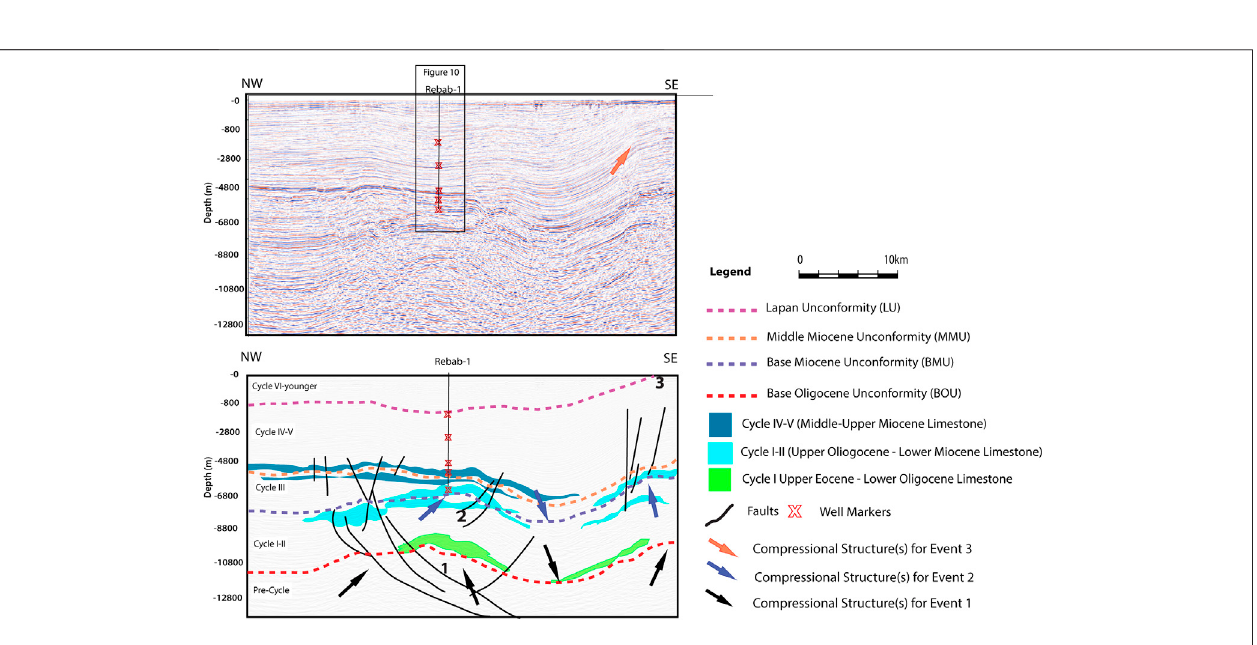
Frontiers in Earth Science |